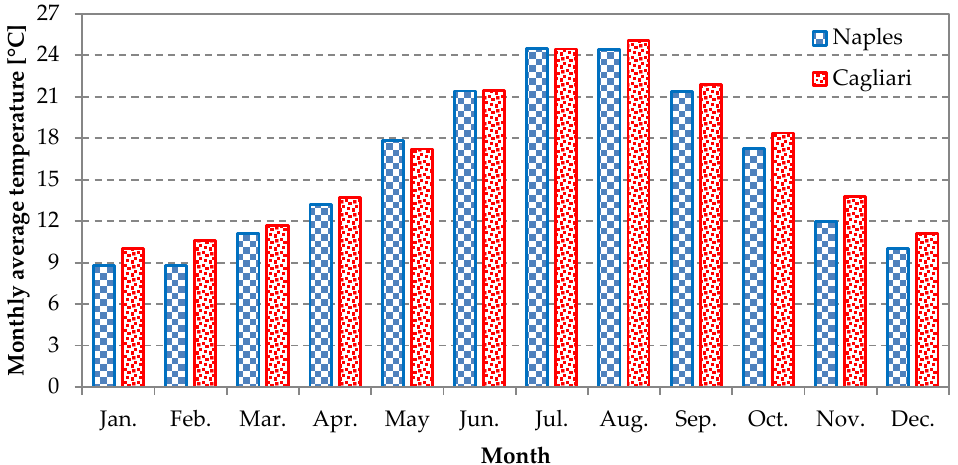
Figure 5. Monthly average temperature from weather data files.